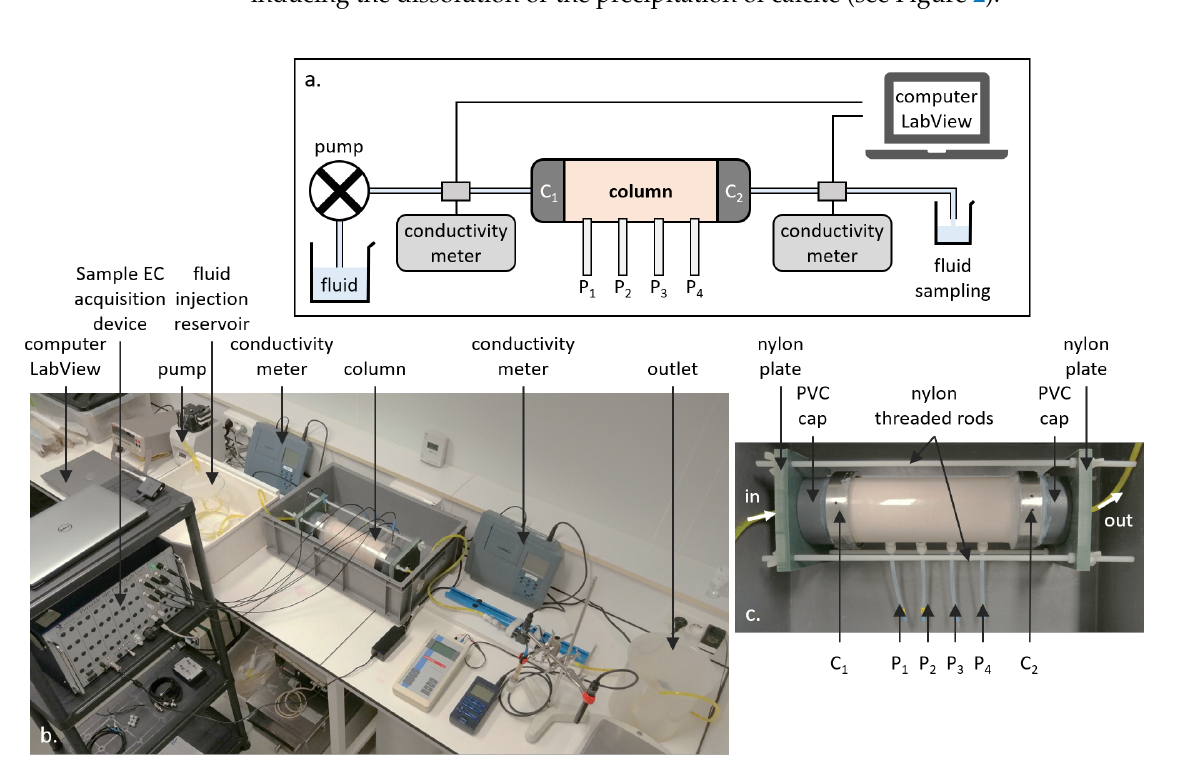
Figure 2. ( a ) Schematic drawing of the experimental setup. C 1 and C 2 are the current electrodes made of stainless steel, while P 1 to P 4 are the silver–silver chloride (Ag-AgCl) unpolarizable potential electrodes. ( b ) Picture of the setup during geo-electrical measurements. ( c ) Picture of the column, which is a Plexiglas cylinder filled with calcite grains. The tightening structure clamps the column and the current electrodes with four threaded rods between two rigid